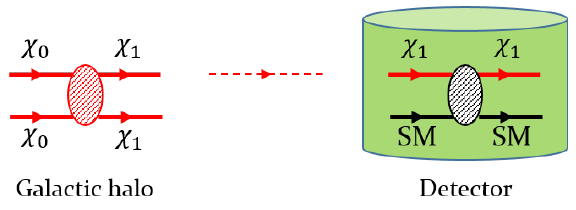
Figure 3 . The minimal BDM scenario and elastic scattering of boosted (lighter) DM at a detector.